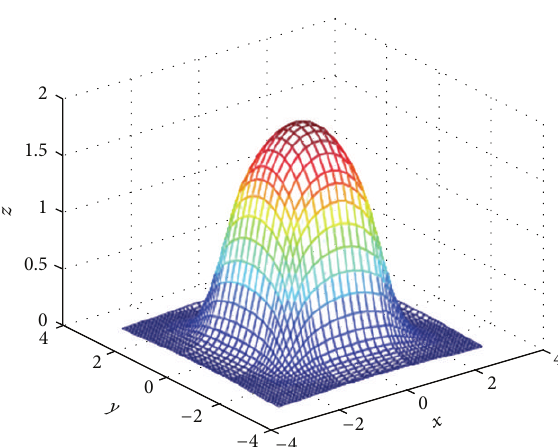
Figure 21: Positivity preserving by using the study of Liu et al. [20] for positive data in Table